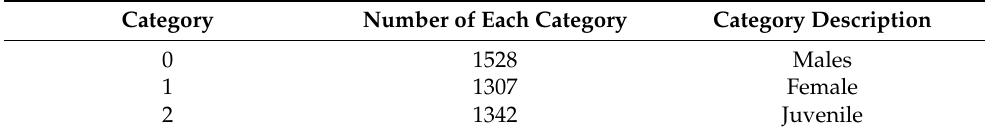
Table 3. Details of the Abalone